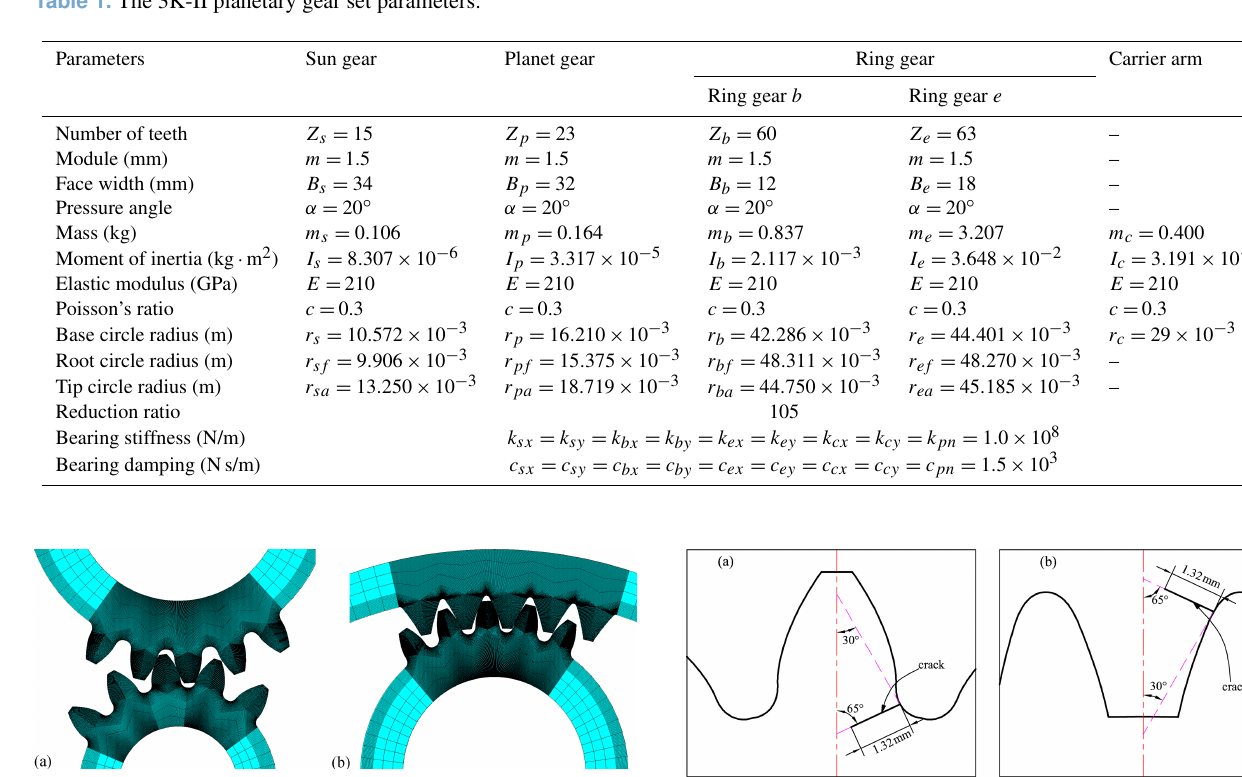
Figure 3. Finite element models for analysis: (a) external gear pair; (b) internal gear pair.